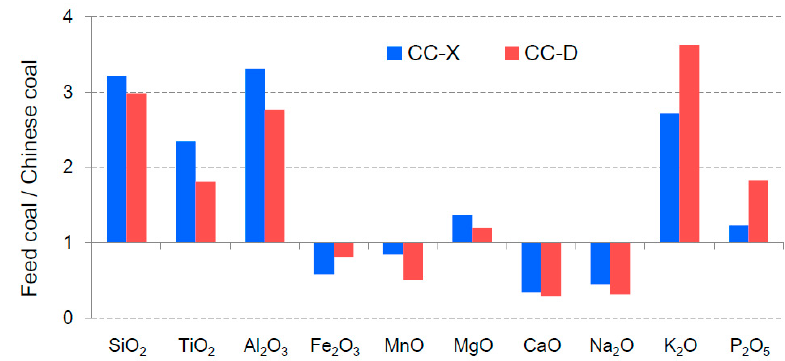
Figure 3. Average concentration coefficient (CC, feed coal vs. Chinese coal) of major elements in the feed coals from the Xilaifeng (X) and Damo (D) power plants.